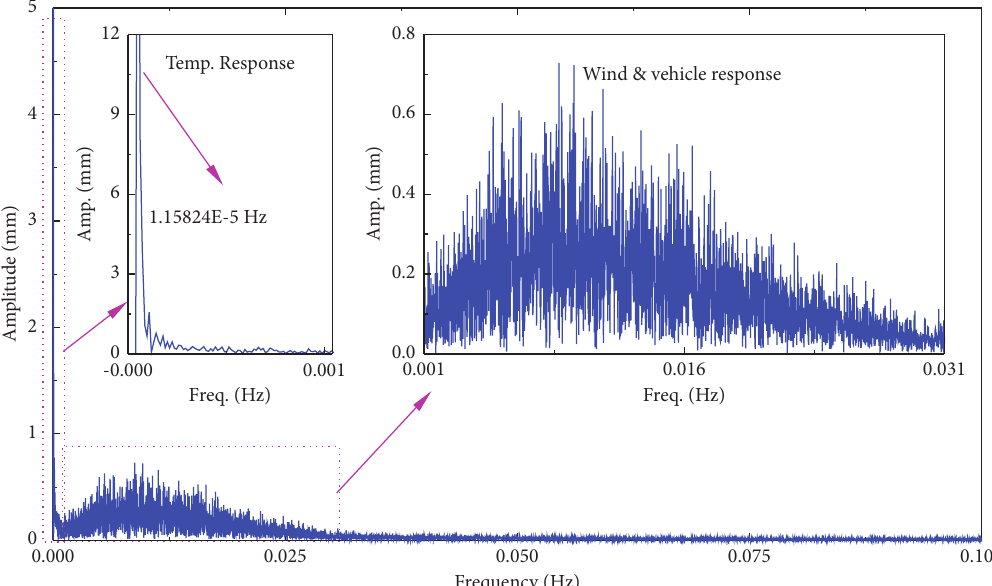
Figure 7: Fourier spectrum curve of daily longitudinal displacement at the girder